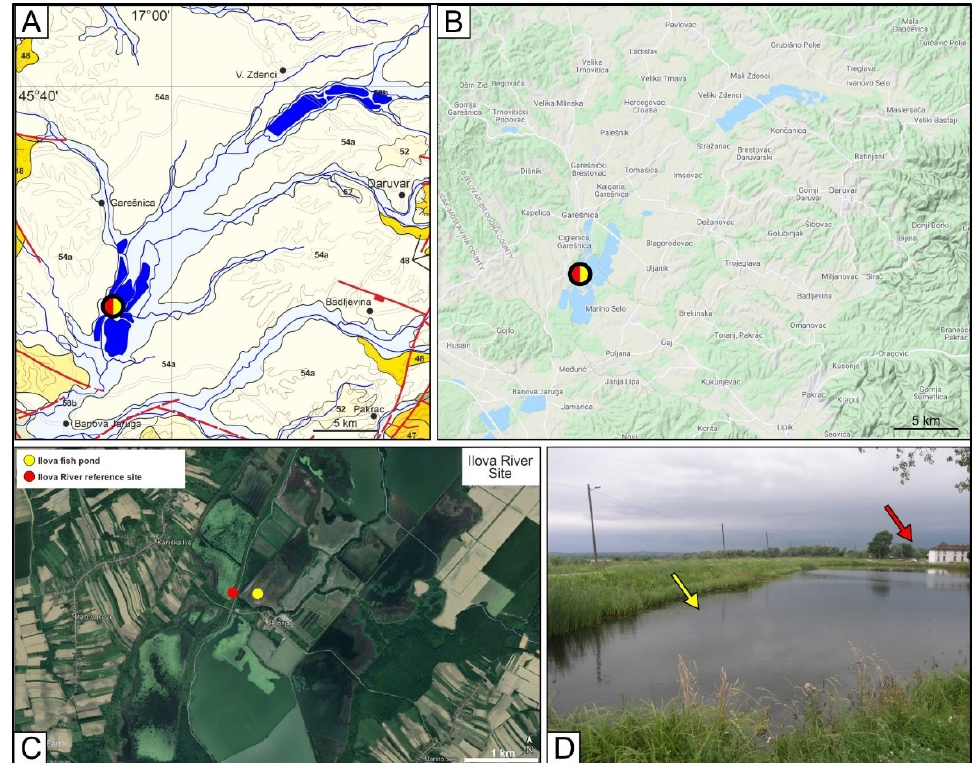
Figure 2. ( A ) Geological map of the Ilova River study site: 47—Miocene limestone-clastic complex; 48—Miocene clastites; 52—Plio-Quaternary clastic deposits; 54a—Pleistocene loess; 58b—Holocene alluvial deposits; blue lines—streams and rivers; blue areas—fishponds; red lines—main faults; thin brown lines—isohipses (after [35,36]). Red/yellow dots represent sampling locations. ( B ) Topographic map of the Ilova study site wider area. Red/yellow dots represent sampling locations. The altitude of the Ilova site is 108 m above the sea. Maximal altitude here is 640 m, near Donji Borki. ( C ) Location of the Ilova River and the Ilova fishpond sampling sites (after Google Earth). Red and yellow dots represent sampling locations. ( D ) Ilova fishpond with exact sampling location (yellow arrow; red arrow indicates sampling point in the Ilova River).